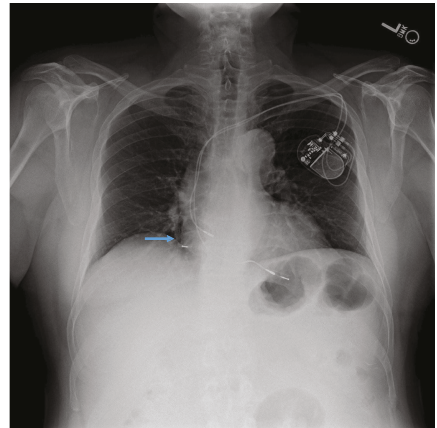
Figure 3: PA chest X-ray showed fractured right atrial lead (blue